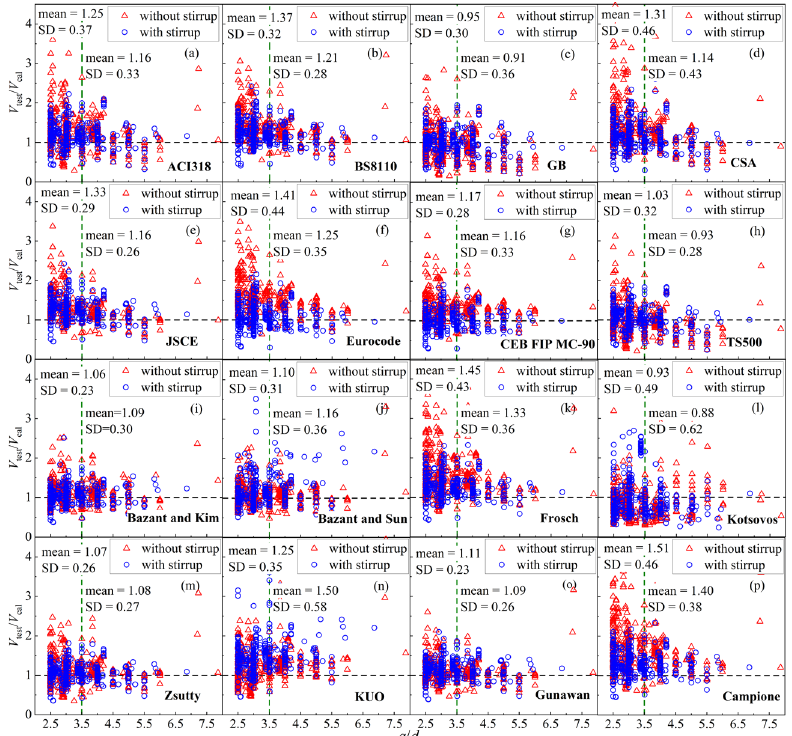
Figure 6. The relationship between the ratios ( V test / V ca l ) and shear span-to-depth ratio of ( a ) ACI318; ( b ) BS8110; ( c ) GB; ( d ) CSA; ( e ) JSCE; ( f ) Eurocode; ( g ) CEB FIP MC-90; ( h ) TS500; ( i ) Bazant–Kim; ( j ) Bazant–Sun; ( k ) Frosch; ( l ) Kotsovos; ( m ) Zsutty; ( n ) Kuo; ( o ) Gunawan; ( p ) Campione.